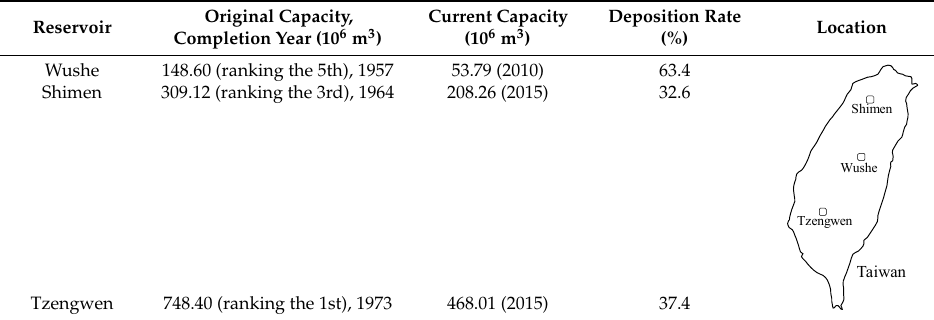
Table 1. Characteristics of three main reservoirs in Taiwan.